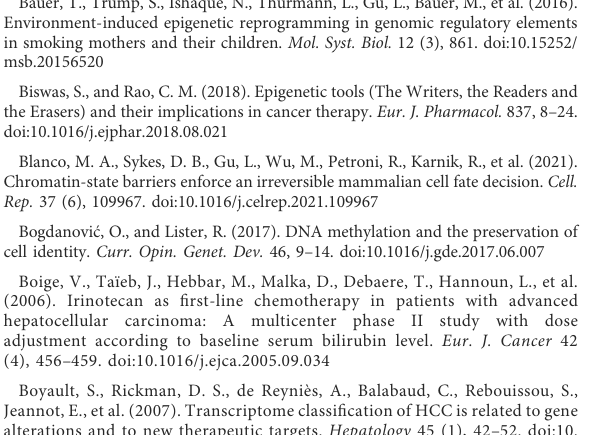
SUPPLEMENTARY FIGURE S1 Molecular features of 5 mC regulators in the TCGA cohort. (A) Mutation landscapeof5 mCregulators. (B) The leftpanel shows thecopynumber variation frequency of 5 mC regulators. The red nodes represent copy number ampli fi cation, while the blue nodes represent copy number deletion. The node size was positively correlated with frequency. The right panel shows the correlation between copy number variation and the level of 5 mC regulator expression. The darker red colors represent a highercorrelationandthenodesizewasnegativelycorrelatedwiththeP value. (C) The left panel showed the methylation of 5 mC regulators. The red nodes represent higher methylation levels in cancer tissues compared with healthy tissues. The blue nodes represent lower methylation levels in cancer tissues compared with healthy tissues. The right panel shows that the correlation between methylation and level of 5 mCregulatorexpression.Theredcolorindicatesapositivecorrelation, while the blue color indicates a negative correlation. The node size was negatively correlated with the P value. (D) The difference in the level of 5 mC regulator expression between cancer and healthy tissues. SUPPLEMENTARY FIGURE S2 The the clinical practice value of 5 mC scores. (A) The GO enrichment analysis of DEGs between the 5 mC clusters. (B) The KEGG enrichment analysis of DEGs between 5 mC clusters. (C) The GO enrichment analysis of DEGs between the high and low 5 mC score groups. (D) The KEGG enrichment analysis of DEGs between the high and low 5 mC score groups. (E) Calibration curve analysis of 5 mC scores. (F – H) The 1-, 3-, and 5-years decision curve analysis of 5 mC scores. SUPPLEMENTARY FIGURE S3 In fi ltration of immune cells using different algorithms. (A) Difference in cancer immunity cycles between clusters 1 and 2. (B – D) Difference in immunecellsinclusters1and2assessedbyCIBERSOT,EPIC,andxCell. *P < 0.05, **P < 0.01, ***P < 0.001. SUPPLEMENTARY FIGURE S4 Association between 5 mC scores and classic molecular subtypes. (A) Boyault, (B) Chiang, (C) Desert, (D) Hoshida, and (E) Yang. ns, not signi fi cant, *P < 0.05, **P < 0.01, ***P <